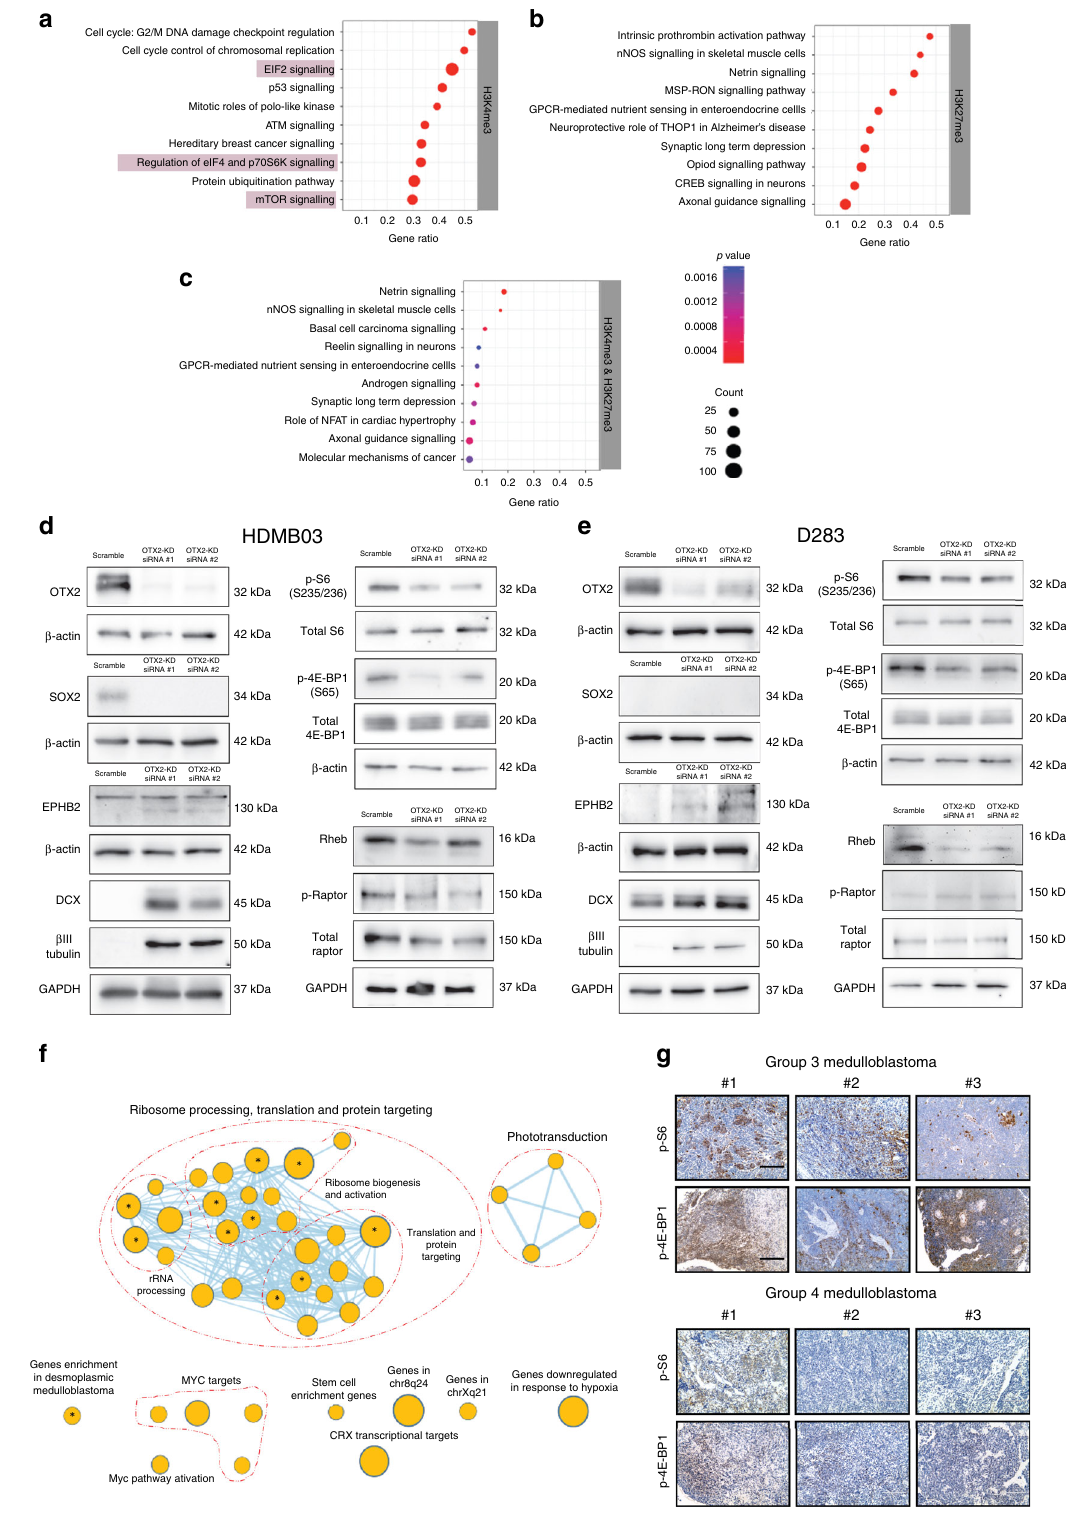
using BioMart 55 . Based on this integrated data, genes containing diffReps identi fi ed H3K4me3 differentially enriched regions in the − 5kb to + 2kb regions around the TSS and H3K27me3-enriched regions over the gene body were generated, and the gene list submitted to Ingenuity Pathway Analysis (https://www. qiagenbioinformatics.com/products/ingenuity-pathway-analysis) to determine enriched pathways and Gene Ontology terms. In addition, OTX2 motifs were identi fi ed in OTX2 peaks 25 using the following motif patterns (TCTAATCCC, TAATCC, TAAGCC, TAATCT, TAACCC) available as a part of the